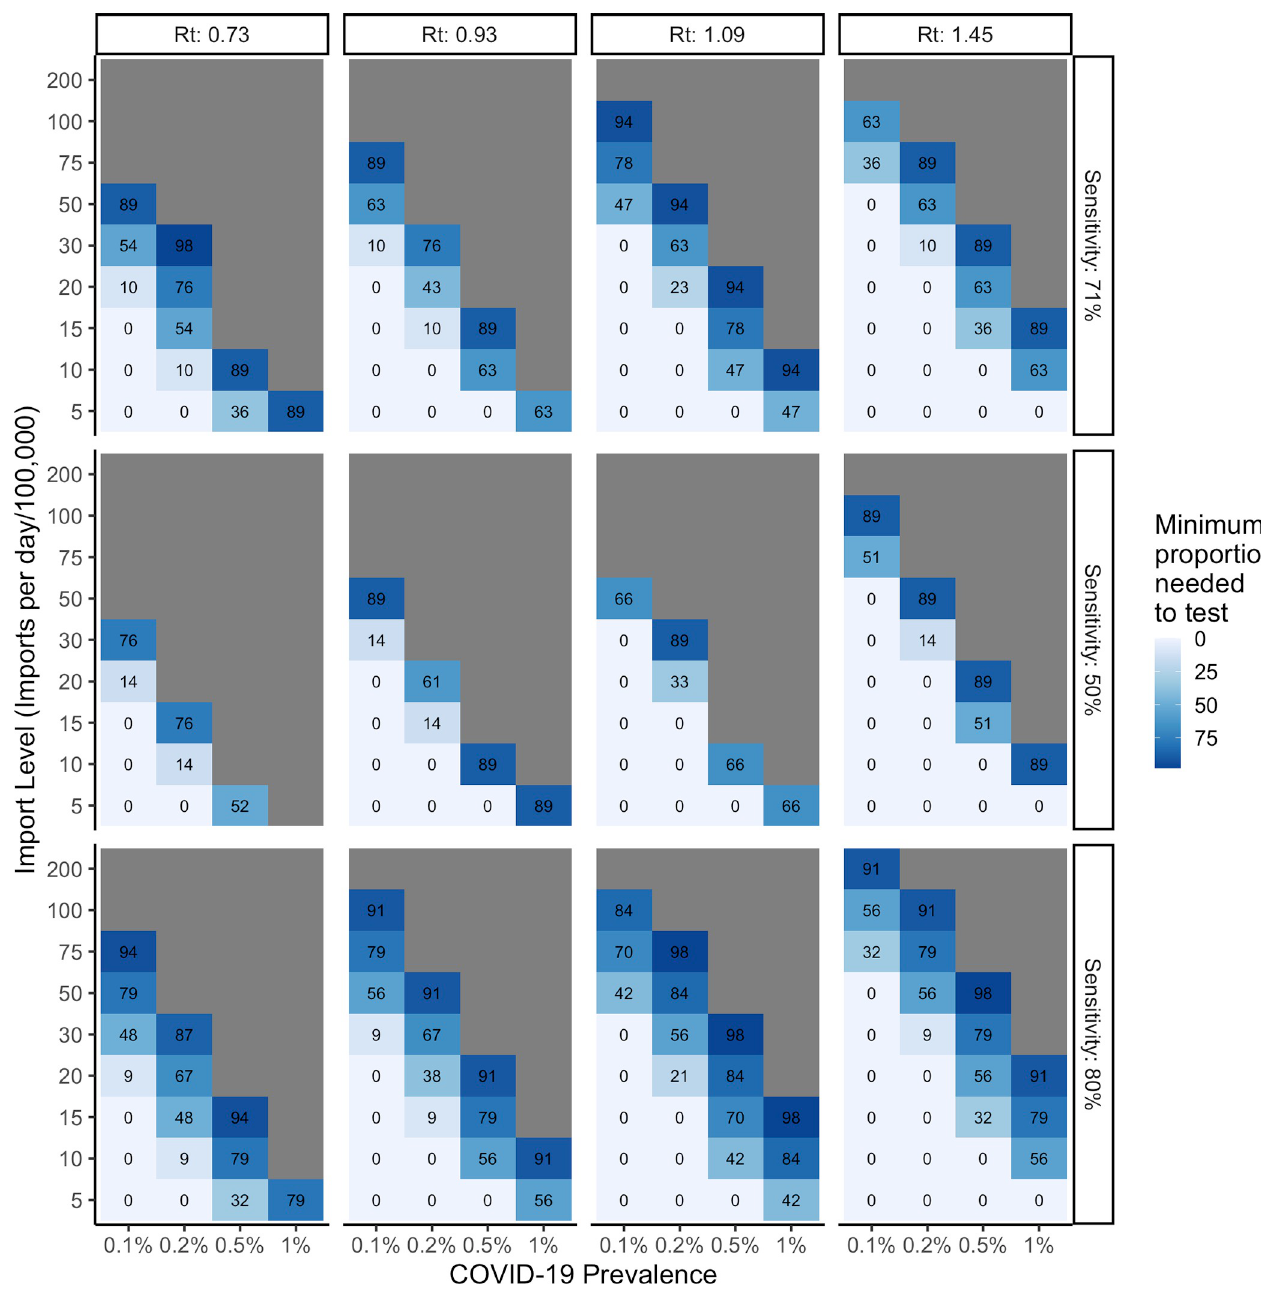
Fig 2. Impact of Ag-RDT test sensitivity on the minimum proportion of all arrivals (land and air) to be screened per day at the border using SARS-CoV- 2 Ag-RDT tests. Varied by the reproductive number at time t , number of arrivals per day, and prevalence of COVID-19 among arrivals. The number in each cell represents the minimum proportion to be tested, while grey cells indicate Ag-RDT screening under the given conditions (even at 100%) is insufficient to prevent a relative 1% increase in community transmission in the host country over the course of one